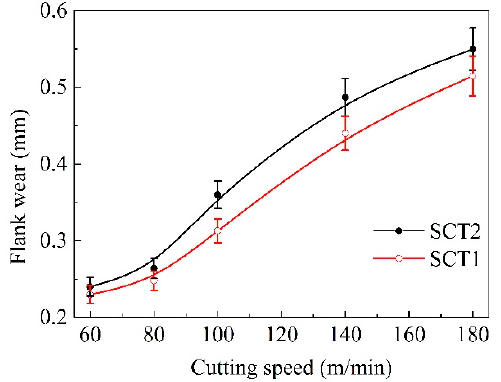
Figure 13. Flank wear of SCT1 and SCT2 tool in dry cutting of hardened steel ( a p = 0.2 mm, f = 0.1 mm/r, cutting time 5 min).